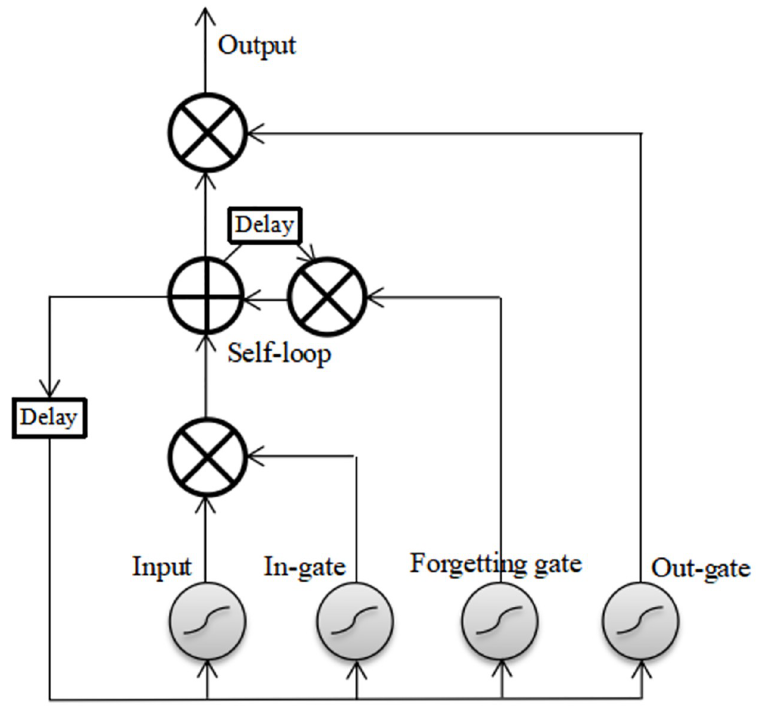
Fig 2. LSTM block model